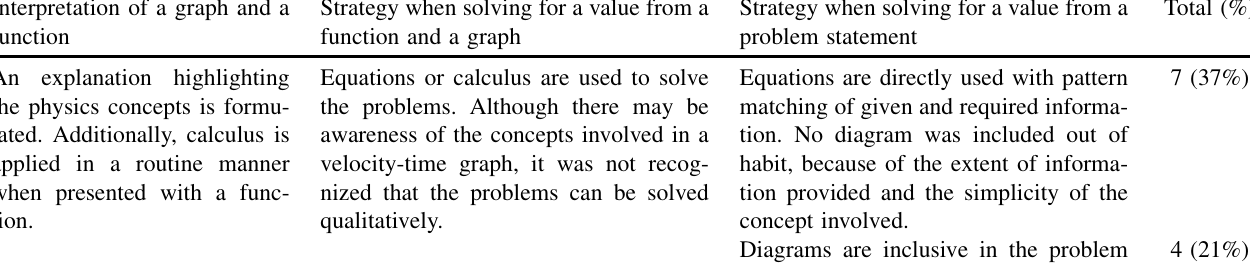
TABLE III. Problem solving strategies for tasks with different representational formats in kinematics. Interpretation of a graph and